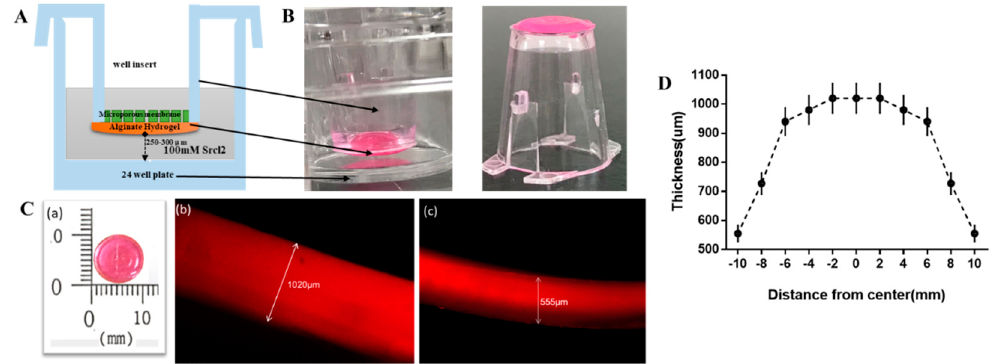
Figure 2. Preparation of experimental materials ( A ) Schematic diagram of transwell-based alginate hydrogel (TAH) homing model. ( B ) For the purpose of scope measurement, alginate hydrogel was dyed with Rhodamine 6G and the appearance of TAH, and ( C ) The top view (a) of actual size of TAH and side views (b and c) using fluorescence microscopy for the measurement of thickness. ( D ) The thickness distribution of the 4% hydrogel film constructed in a TAH model.